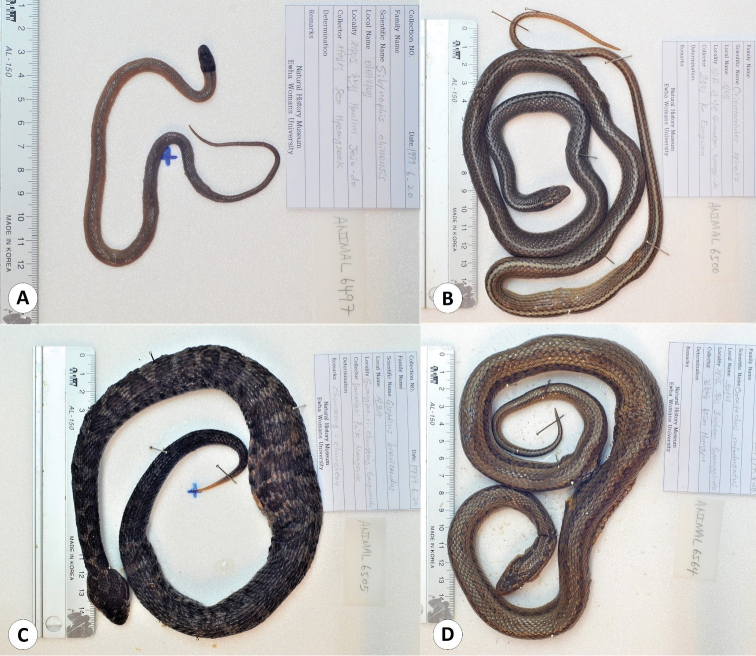
Some of the snake specimens deposited in the collection of the EWNHMASibynophis
chinensis (EWNHM-ANIMAL 6497) BOrientocoluber
spinalis (EWNHM-ANIMAL 6500) CGloydius
brevicaudus (EWNHM-ANIMAL 6505) DOocatochus
rufodorsatus (EWNHM-ANIMAL 6564).